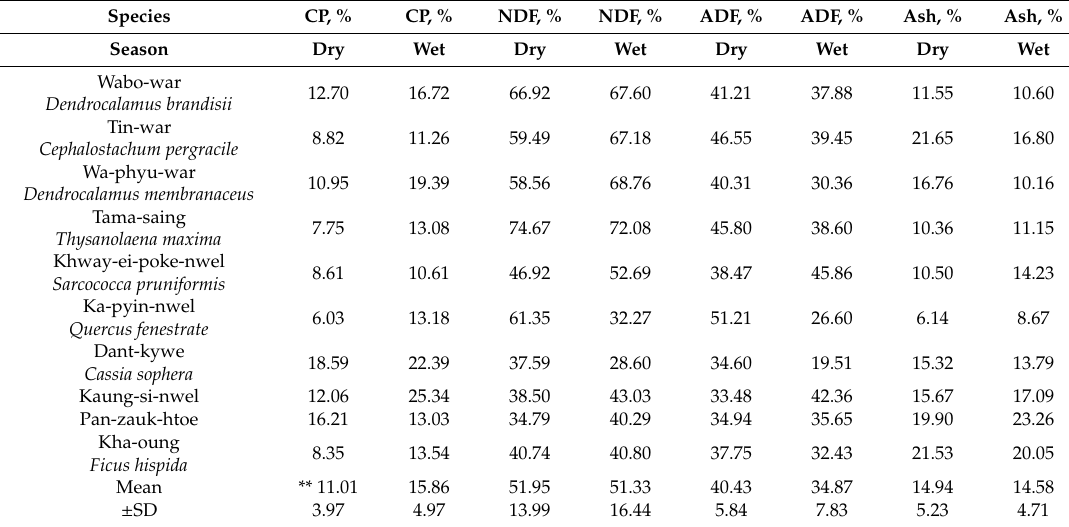
Table 4. Chemical composition of primary natural forages consumed by Asian elephants during late lactation near Katha, Myanmar. Data presented on a dry matter basis.